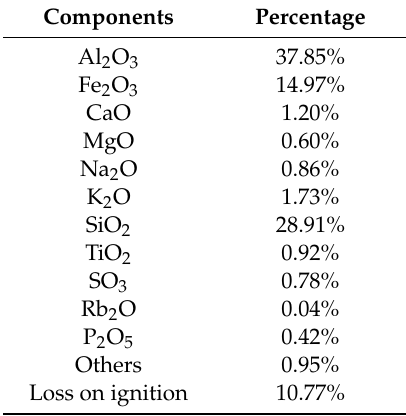
Table 1. The composition of alum